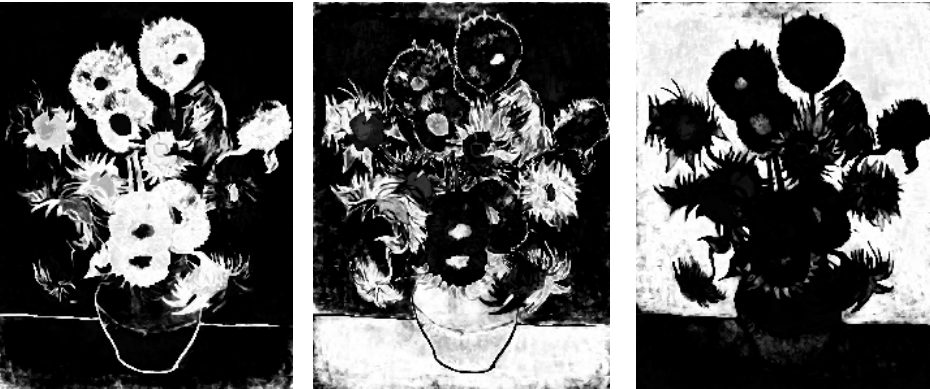
Figure 10. Sunflowers G Band—compression rate 0.25—segmented images.